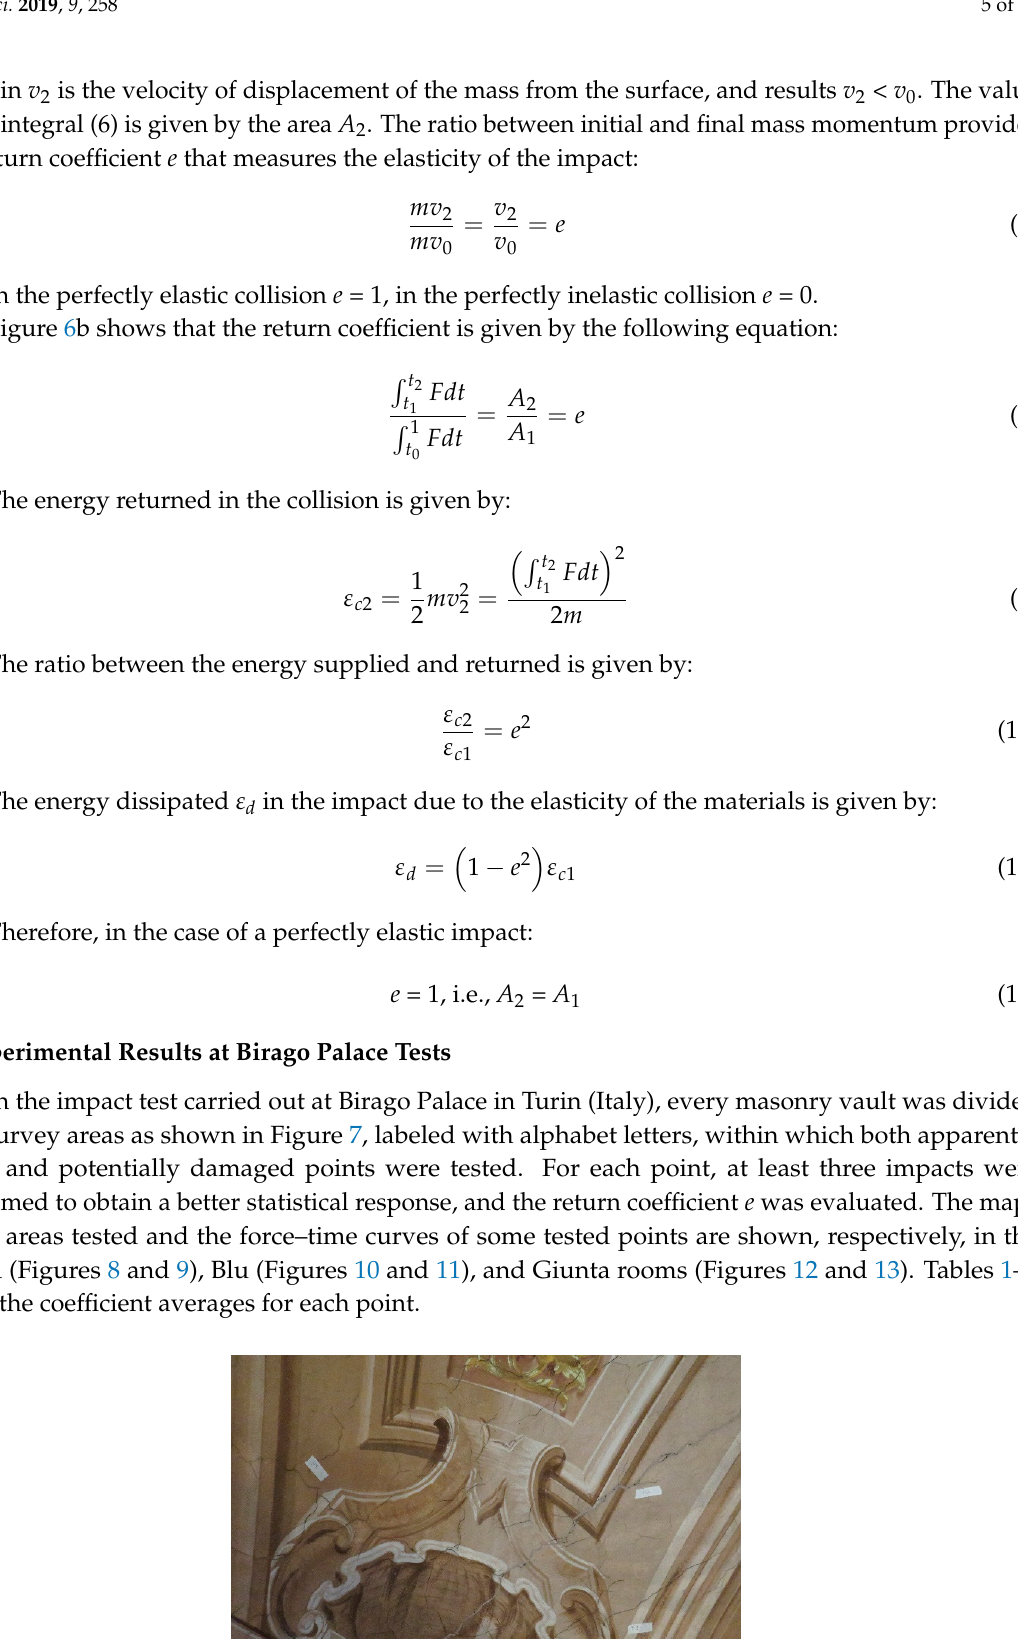
Figure 8. Map of the points and areas tested on the vault of the Pelagi room. Table 1. Results of impact test on Pelagi room vault. Area Test Point e = A 2 / A 1